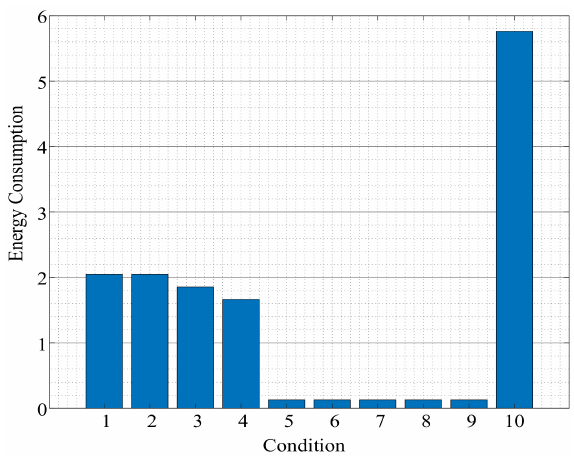
Figure 5. Energy for second line